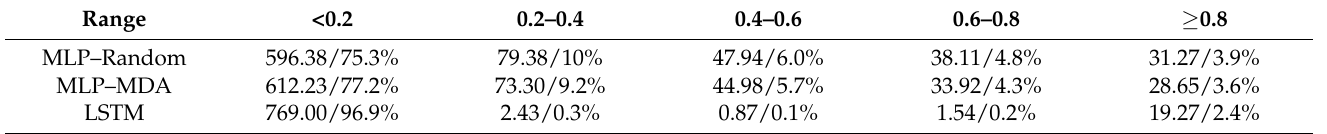
Figure 4. USI map of the study area from ANNs. ( a ) MLP with random sampling; ( b ) MLP with MDA sampling; and ( c ) LSTM. Table 2. Proportions of areas for five groups of USI values predicted with three methods (unit: km 2 /%).